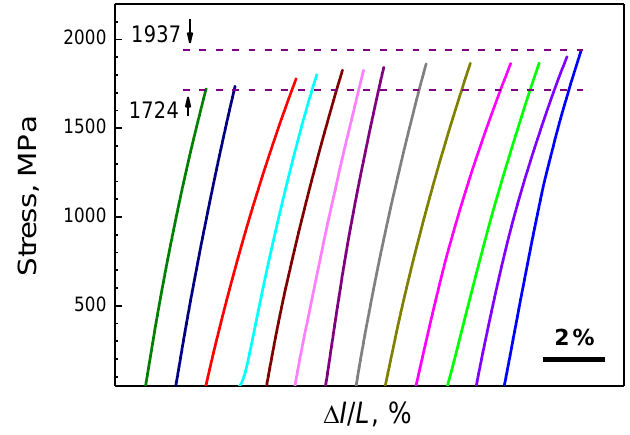
Figure 4. Engineering stress-strain curves of Cu 48 Zr 48 Al 4 amorphous microwires at room temperature.